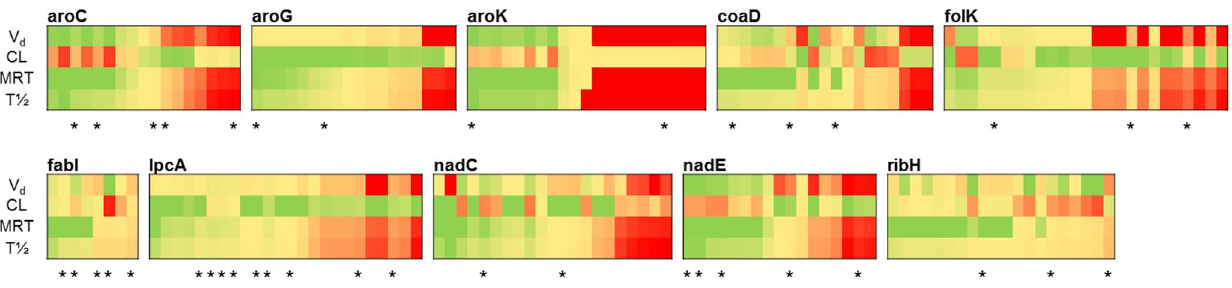
Figure 3. Distribution of calculated pharmacokinetic parameters. Predicted PK parameters for each of the set of 190 candidate compounds are shown. Each column represents one compound, and compounds are grouped according to their target. PK parameter values are represented by a color spectrum ranging from ‘‘undesirable’’ (red) to ‘‘desirable’’ limits (green), defined by the respective 10 and 90 percentile values among the set of Federal Drug Administration-approved drugs for each parameter. For volume of distribution (V d ), the limits were , 0.25 l/kg (red) and . 3.30 l/kg (green). For clearance (CL), the limits were . 4.5 ml ? min 2 1 ? kg 2 1 (red) and , 1.30 ml ? min 2 1 ? kg 2 1 (green). For mean residence time (MRT), the limits were , 1.0 h (red) and . 14.0 h (green). Finally, for half-life ( T K ), the limits were , 1.5 h (red) and . 13.0 h (green). The 40 compounds selected for experimental testing are highlighted (). The putative protein targets are shown in Table 2.